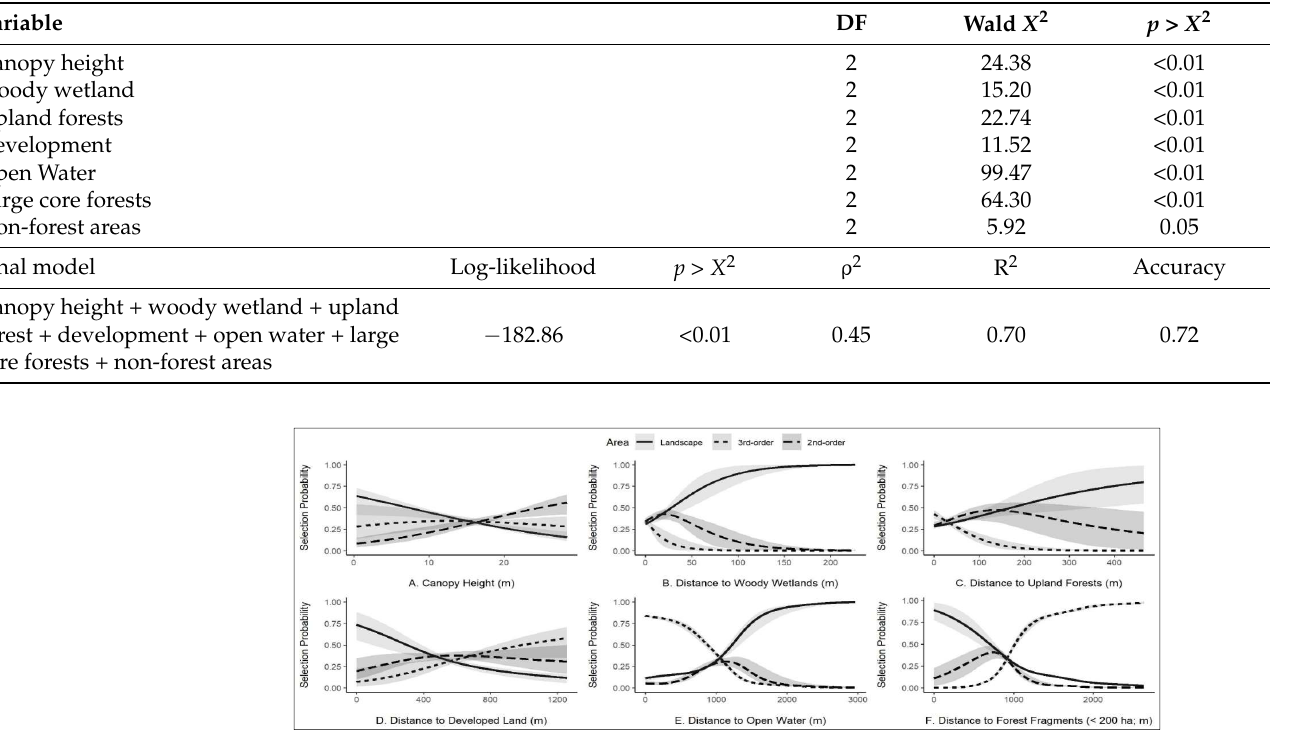
Figure 2. Partial effect plots describing the relation of ( A ) canopy height and distance to ( B ) woody wetlands, ( C ) upland forests, ( D ) developed land, ( E ) open water, and ( F ) forest fragments with northern long-eared bat ( Myotis septentrionalis ) habitat at multiple spatial scales at the North Caro- lina Wildlife Resource Commission’s North River Game Land (NRGL) in Camden and Currituck counties, North Carolina, 2019.